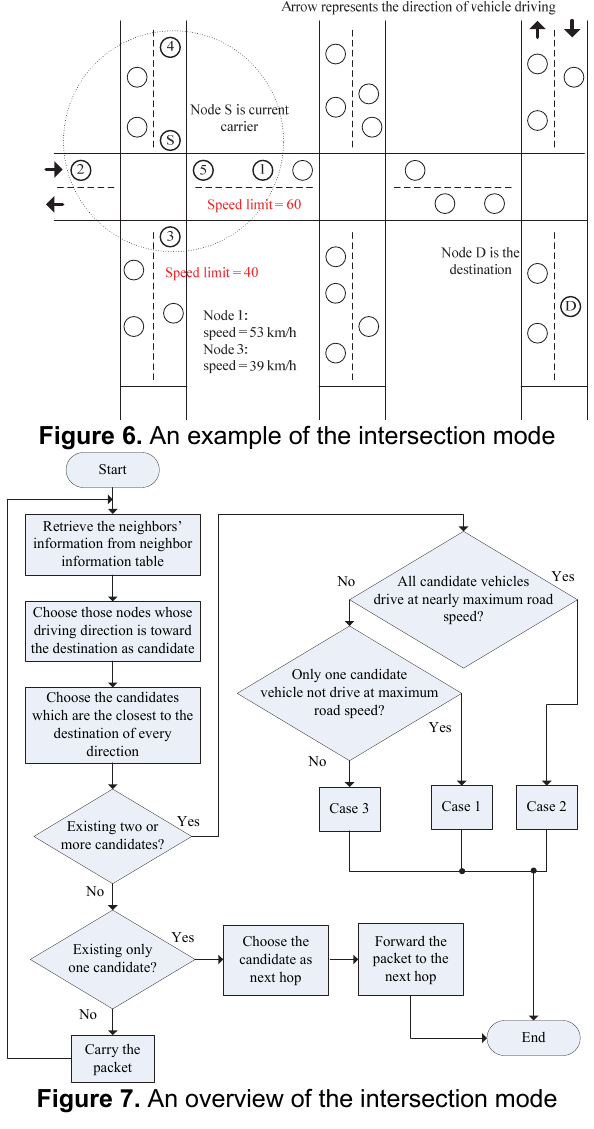
Figure 7. An overview of the intersection mode CASE 1- Only one candidate node driving slower than the maximum road